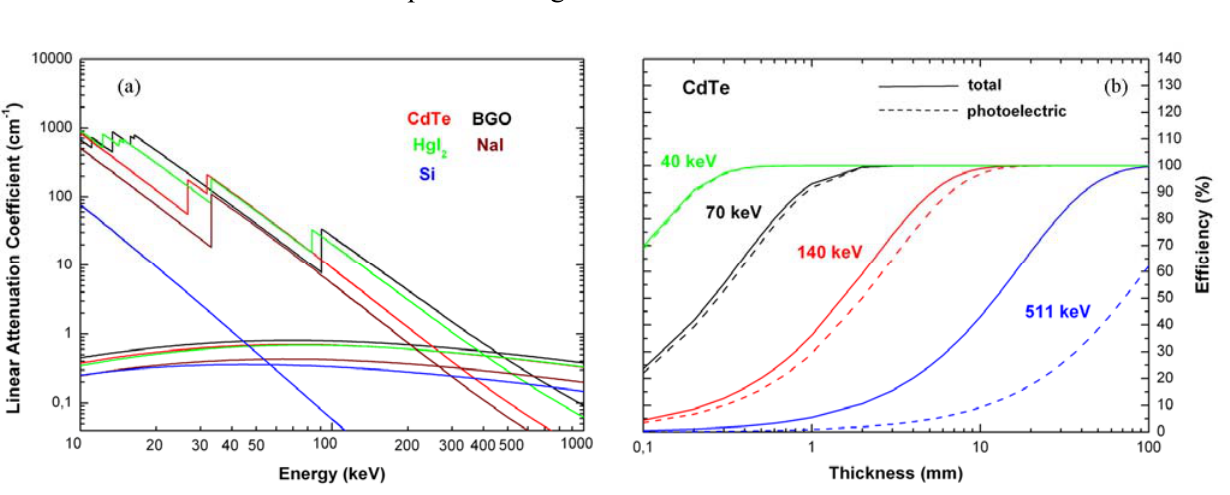
Figure 1. (a) Linear attenuation coefficients for photoelectric absorption and Compton , NaI and BGO. (b) Efficiency of CdTe detectors as function of scattering of CdTe, Si, HgI 2 detector thickness at various photon